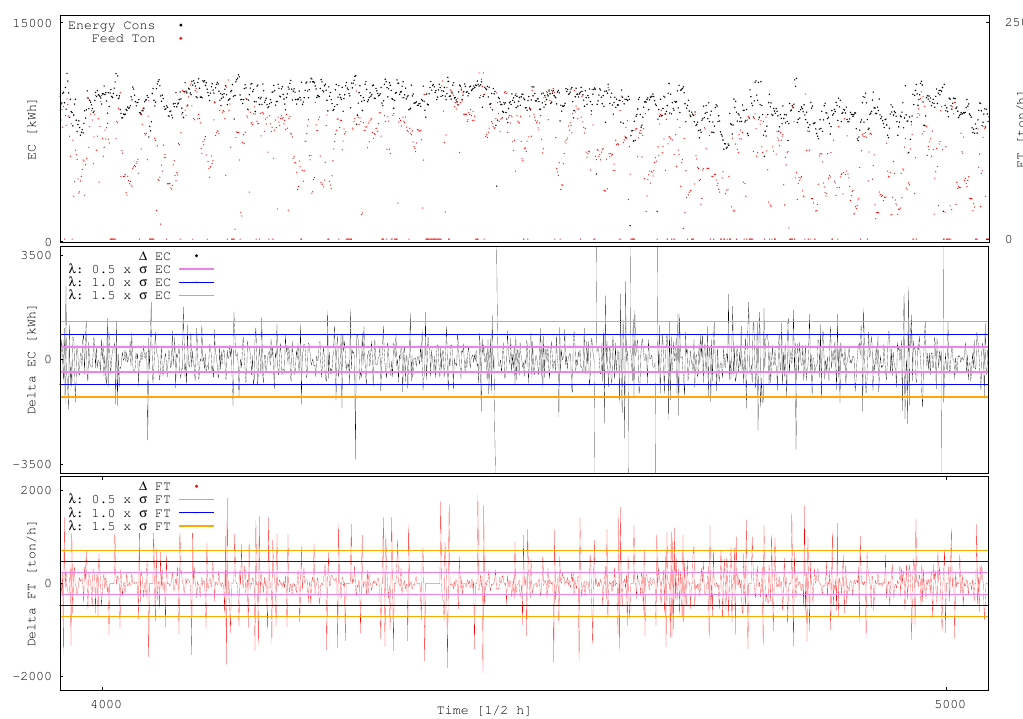
Figure 2. SAG mill 1. Graphic representation of the relative-hardness inference criteria at 0.5 h time support. Daily graphs of energy consumption and feed tonnage ( top ), delta of energy consumption ( centre ), and delta of feed tonnage ( bottom